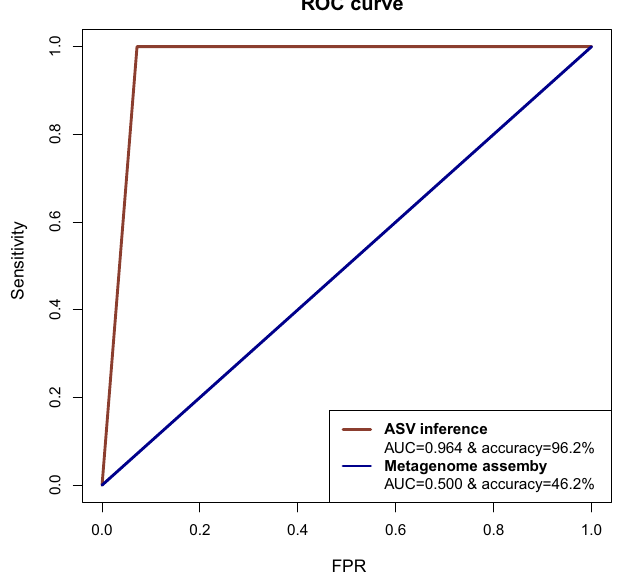
Figure 2. Performance of two distinct pipelines to identify co-infection by SARS-CoV-2 VOCs. Metrics for the whole-genome assembly, with AUC = 0.5 and accuracy = 46.2%, suggest no discrimination of the VOCs among samples, with a misclassification of all the cases with two variants. In contrast, the ASV-like inference was able to correctly identify VOCs in cases with one or two variants, with an outstanding performance according to the AUC = 0.964 and accuracy = 96.2%. FPR: False Positive Rate.